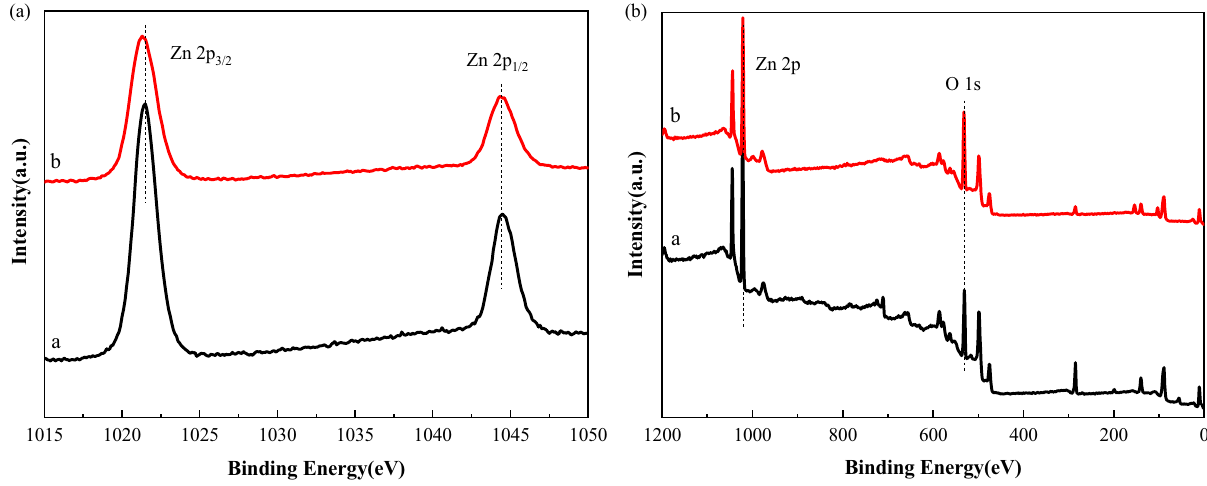
Figure 3: XPS ( a ) and Zn 2p ( b ) characterization of catalyst: (( a ) Fe 3 O 4 – ZnO and ( b ) Fe 3 O 4 @SiO 2 – ZnO ) . ( Zinc chloride was used as zinc source )